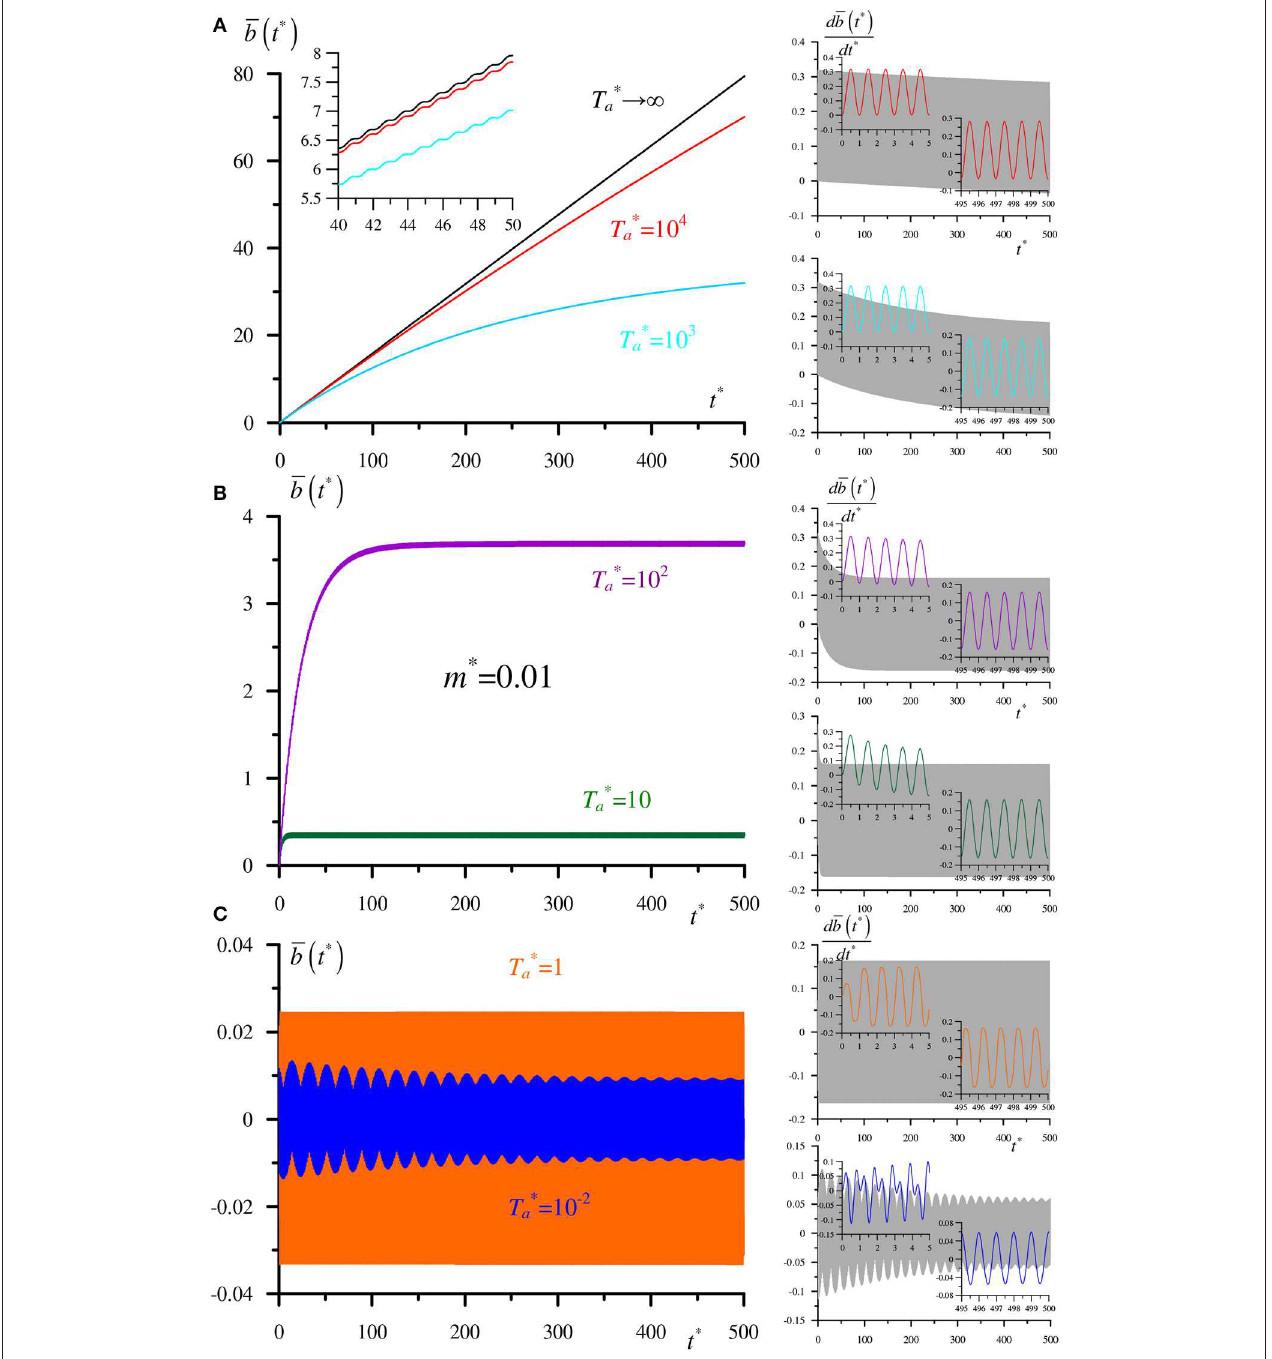
FIGURE 9 | Normalized tangential displacement (at the left) and corresponding velocity (at the right) for different excitation amplitudes T ∗ a for m * = 0.01: (A) T ∗ a → ∞ , T ∗ a = 10 4 , and T ∗ a = 10 3 ; (B) T ∗ a = 10 2 and T ∗ a = 10; (C) T ∗ a = 1 and T ∗ a = 10 − 2